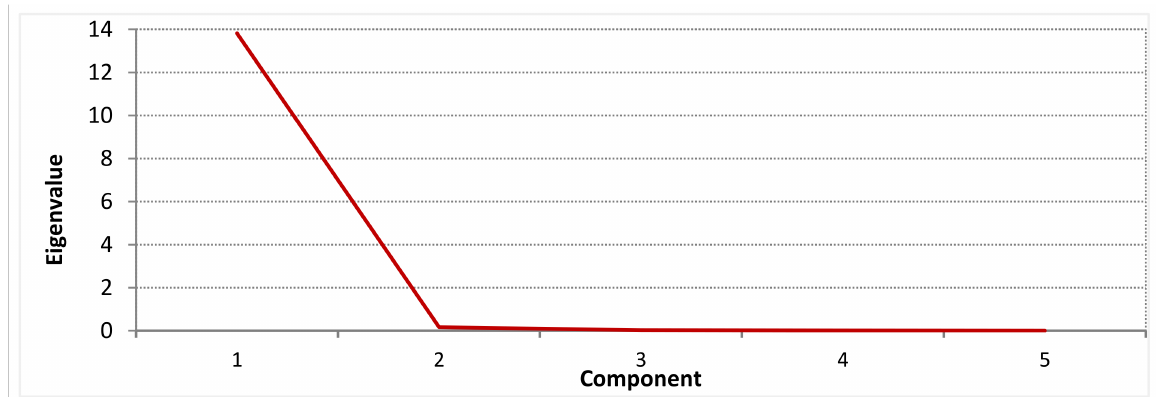
Figure 4. Scree plot of PCA components for chamomile plant parameters in response to CSNPs treatments.